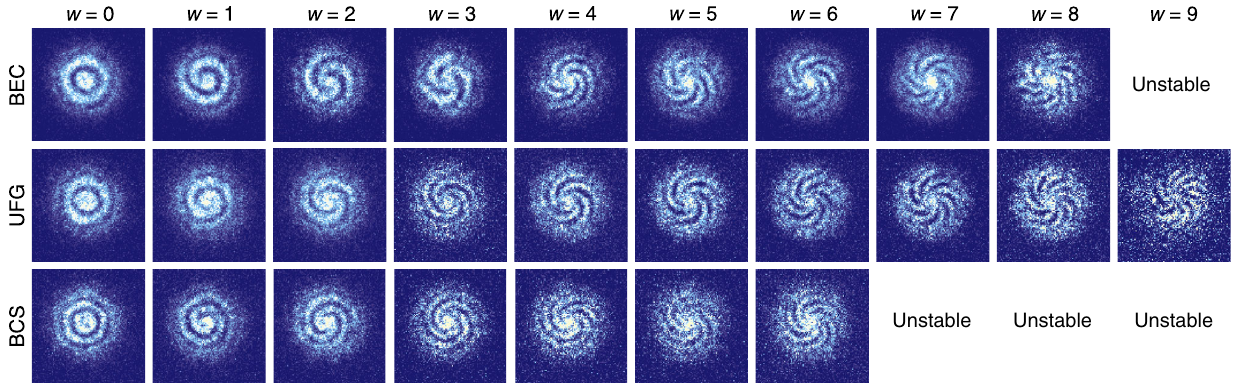
FIG. 6. Interferograms across the BEC-BCS crossover, acquired after a 1.2-ms TOF expansion. Images are obtained by averaging 2 – 4 single experimental shots. The color scales in the rows are normalized differently to compensate for the lower interference contrast in UFG and BCS